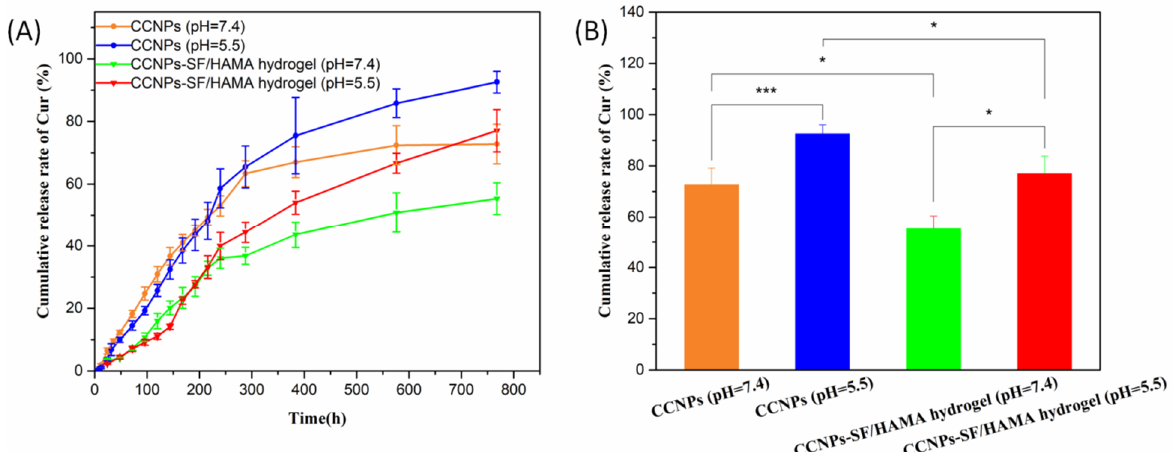
Figure 7. Cur release of the CCNPs and CCNPs-SF/HAMA hydrogels in different pH ( A ). Cumulative release of the CCNPs and CCNPs-SF/HAMA hydrogels in 32 days ( B ). Data are expressed as mean ± SD ( n = 4); * p < 0.05, and *** p < 0.001 are differences between the indicated groups.